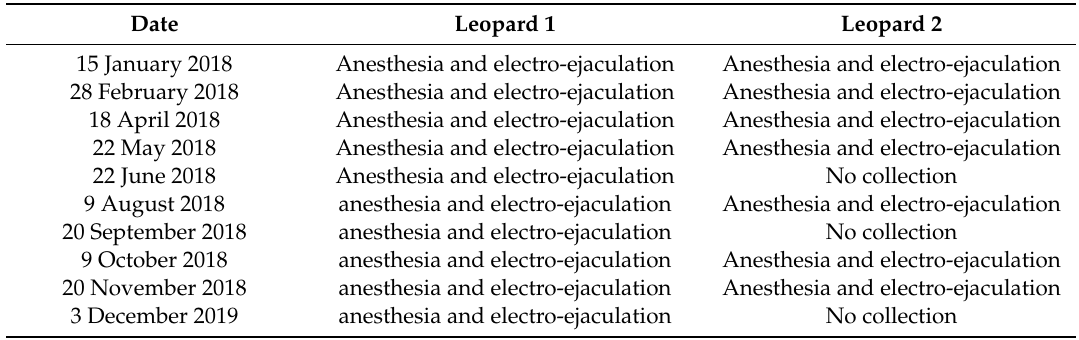
Table 1. Dates of anesthesia and electro-ejaculation procedures in two Sunda clouded leopards living